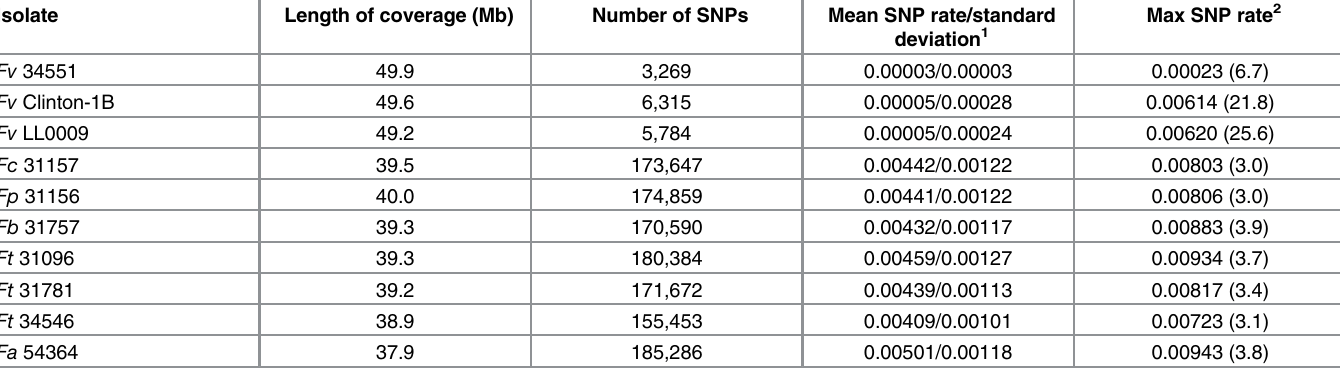
Table 2. Length of coverage and distribution of SNPs when reads were mapped onto reference Fv Mont-1. Isolate